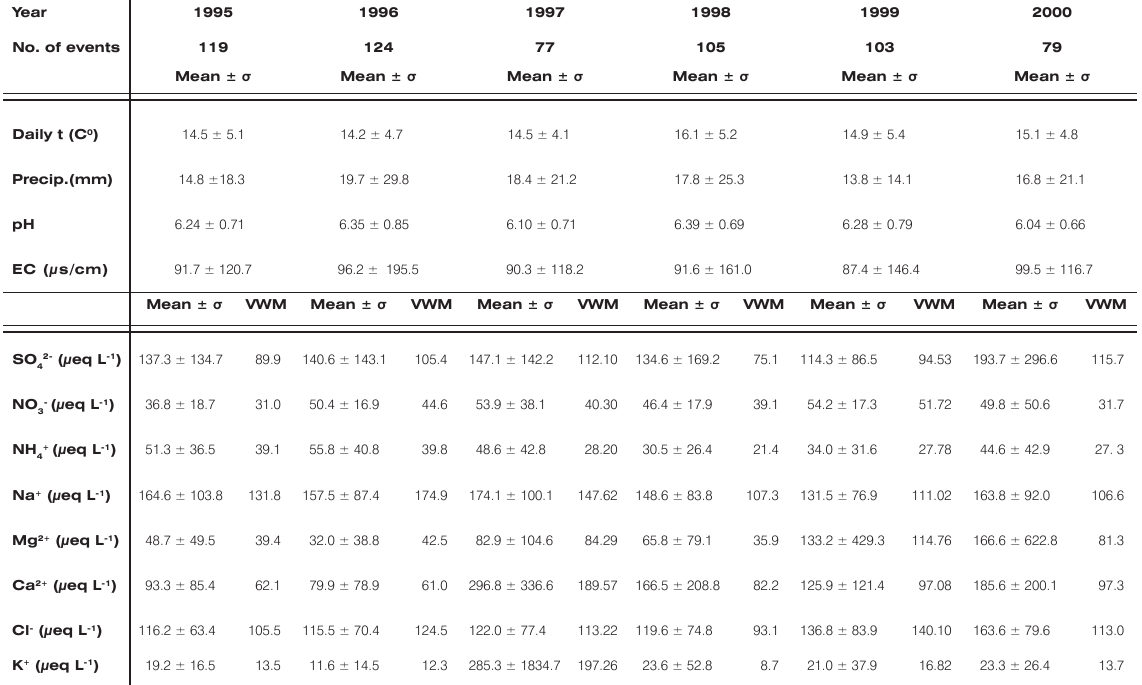
Table 2. Average yearly values of measured